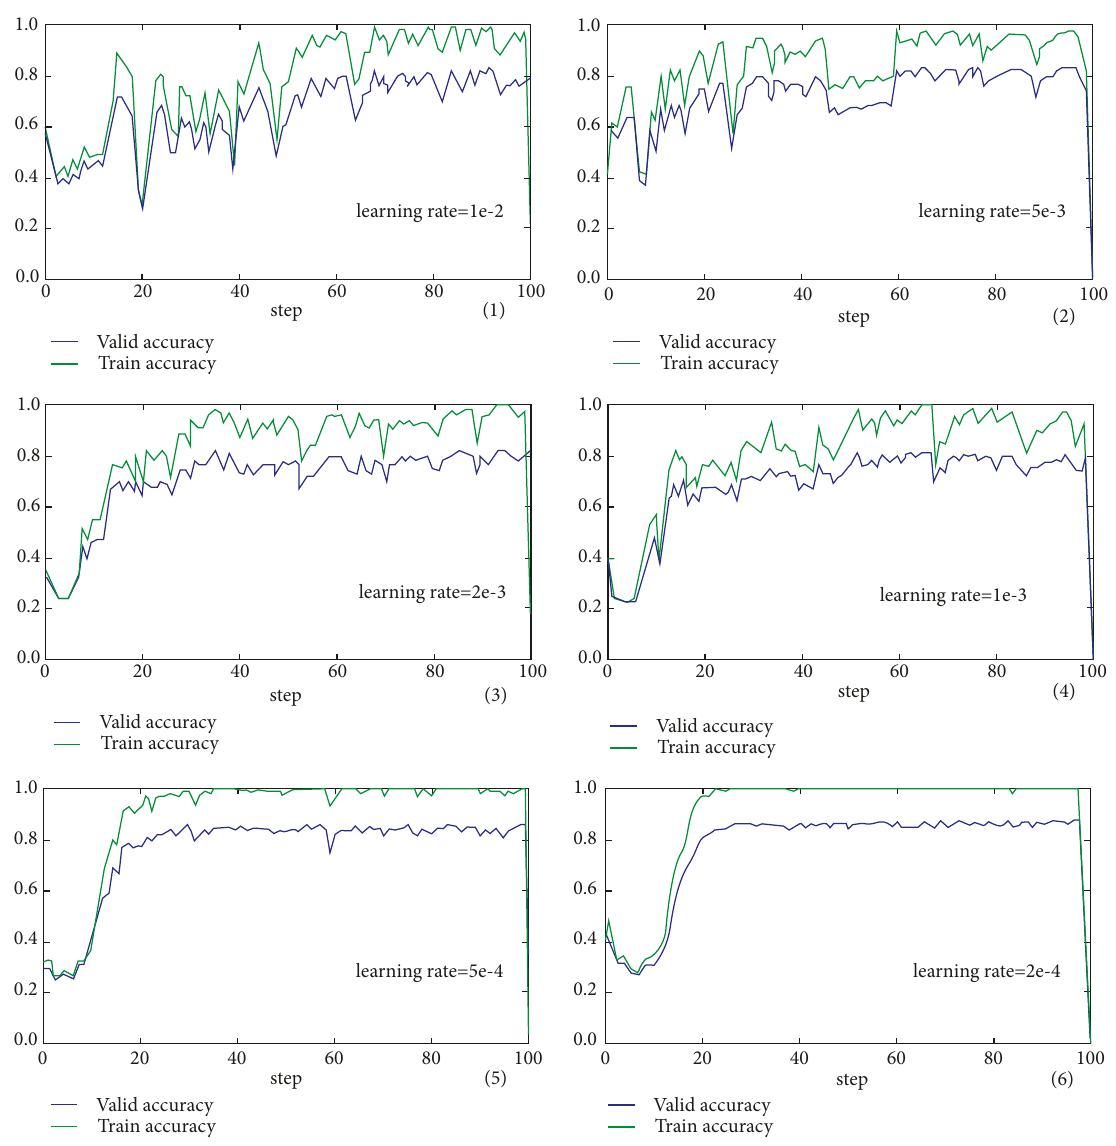
Figure 11: Changes of correct rate under different learning rates in training process